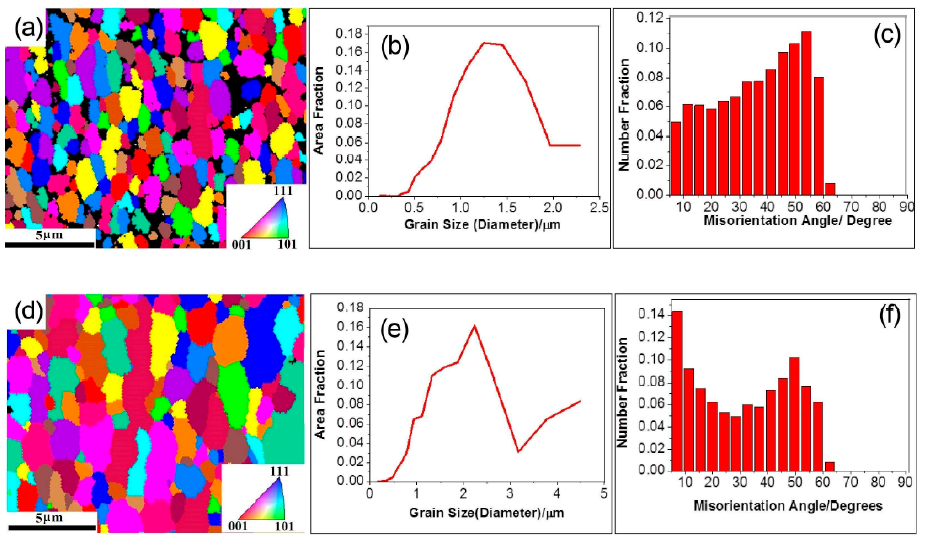
Figure 18. EBSD maps of equiaxed grains for three-pass friction stir processing (FSP)-processed sample at a rotational speed of 300 r/min: ( a ) orientation map, ( b ) distribution of grain size and ( c ) misorientation angle distribution in stir zone (SZ), and ( d ) orientation map, ( e ) distribution of grain size and ( f ) misorientation angle distribution in transition zone (TZ) [114]. Reprinted with permission from reference [114] 2017 Elsevier.